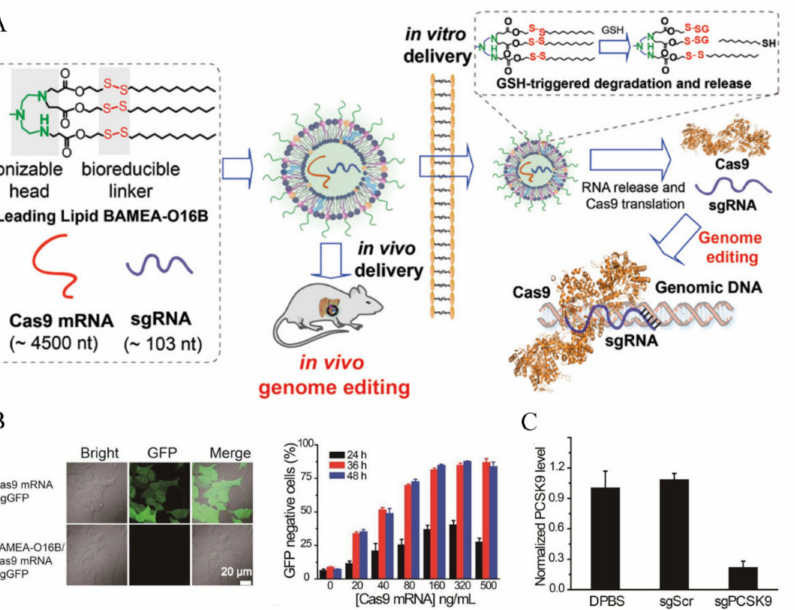
Figure 7. Fast and efficient Cas9 mRNA and sgRNA delivery by bioreducible lipid nanoparticles. ( A ) Schematic diagram of BAMEA-O16B lipid nanoparticle for Cas9 mRNA and sgRNA delivery. ( B ) CLSM images and quantitative analysis of GFP expression of HEK-GFP cells.